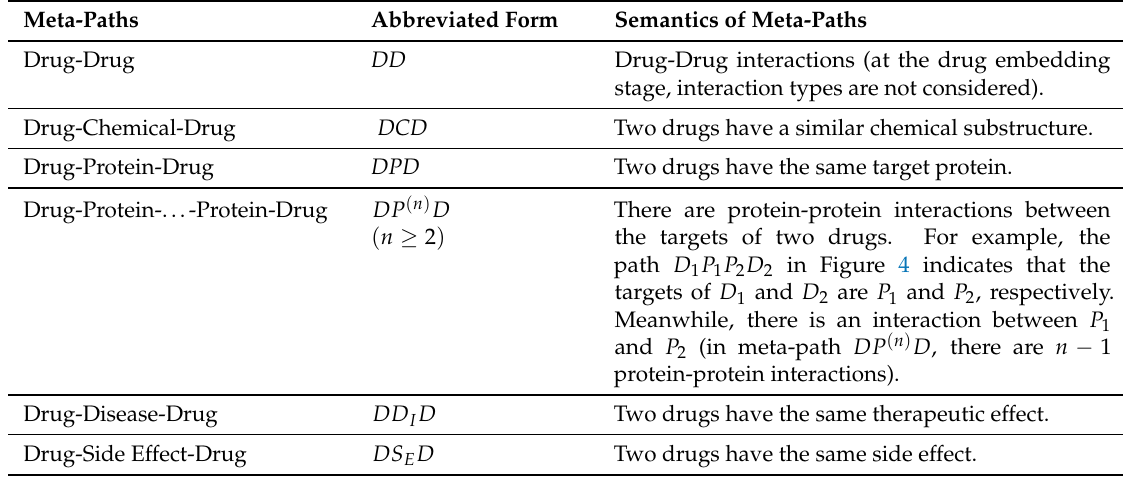
Figure 3. Meta-paths in drug HIN. Table 3. Meta-paths in drug